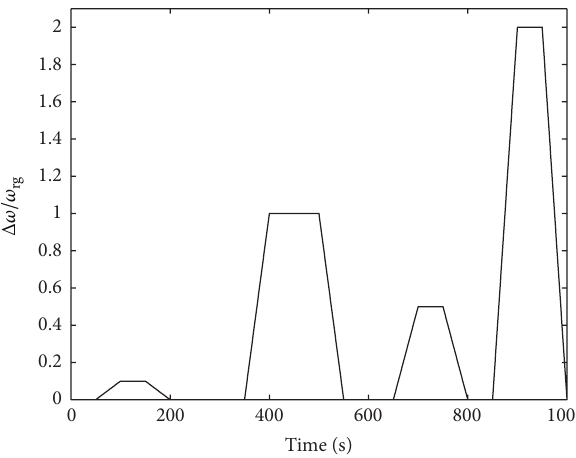
Figure10:(a)Yieldofadifferentialgearbox 𝜂 asafunctionoftheloadparameter Δ𝜔/𝜔 di (0.03, 0.05) in a dashed line, (0.05, 0.07) in a dash-dot line, (0.03, 0.07) in a dotted line and in a solid line for (𝜇 a concomitant linear increase from (0.03, 0.05) to (0.05, 0.07) and 0.98 to 0.96 , respectively, with Δ𝜔/𝜔 of the differential gearbox without any losses (which is constant) with the load parameter Δ𝜔/𝜔 = 𝑃 /𝑃 𝑙 of the 𝑖 -mechanism (with 𝑖 = ( sa / pl , ax / sa , sa / sh , pl / sh ) ) as a function of the load parameter Δ𝜔/𝜔 𝑖 𝑖 rg without (black solid line) or with (black dashed line) a linear decrease in 𝜂 coefficients of friction as in (a): 𝑙 sa / pl (red line), 𝑙 (blue line), and 𝑙 (green line). sa / sh pl / sh